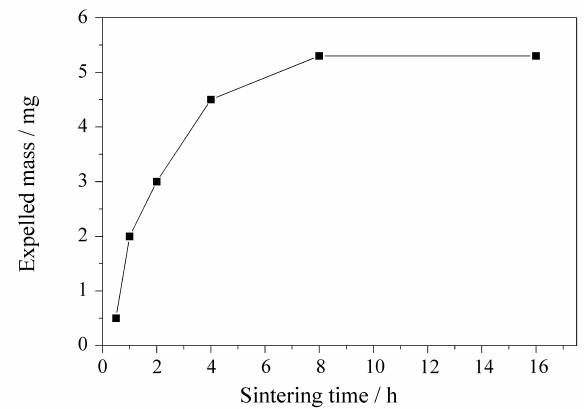
Figure 5. Expelled glass phase mass for several sintering times at 1610 °C.